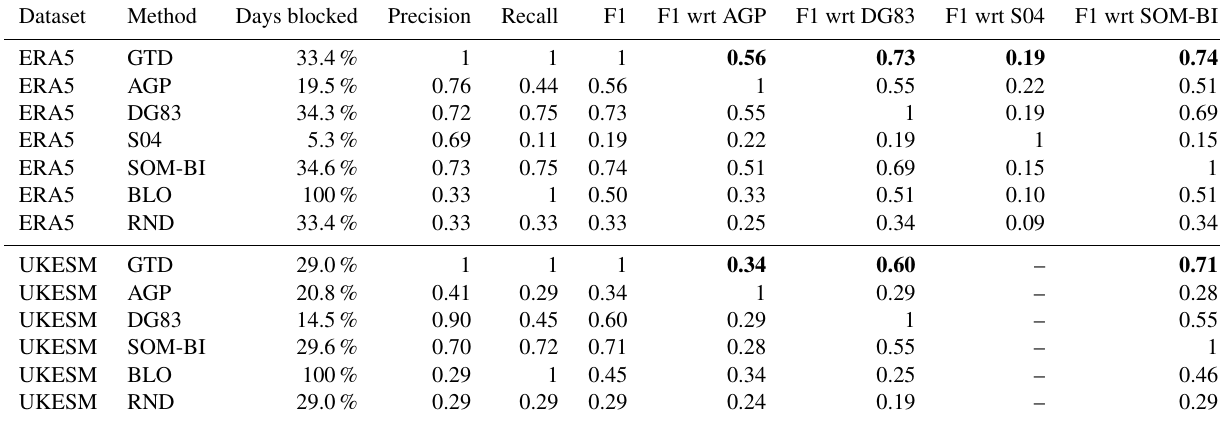
Table 1. A comparison of skill scores of the original BIs and the new SOM-BI against the GTD for ERA5 1979–2018 and UKESM for JJA over the European domain. Where not indicated the skill scores are measured with respect to the relevant GTD. “BLO” indicates the skill score for the trivial case of every day labelled as blocked and “RND” where a random allocation of blocked days has occurred with the same proportion of blocked days as the